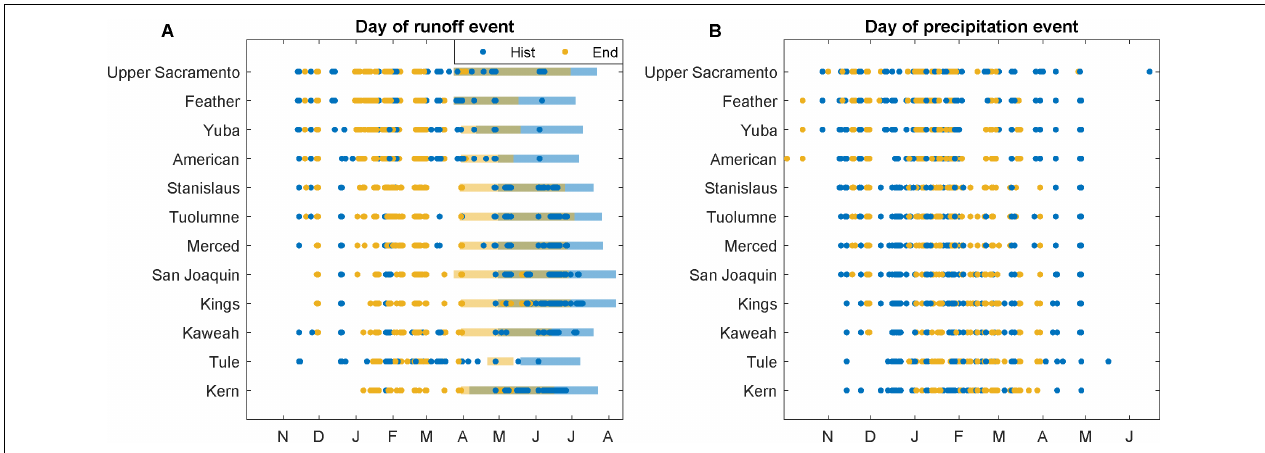
FIGURE 13 | Timing of extreme (A) runoff and (B) precipitation events for each Sierra Nevada basin for the historic and end-century periods. Events at or above the 99th percentile are shown, for a total of 37 events. In (A) , colored bars indicate the average snowmelt season over each decade.